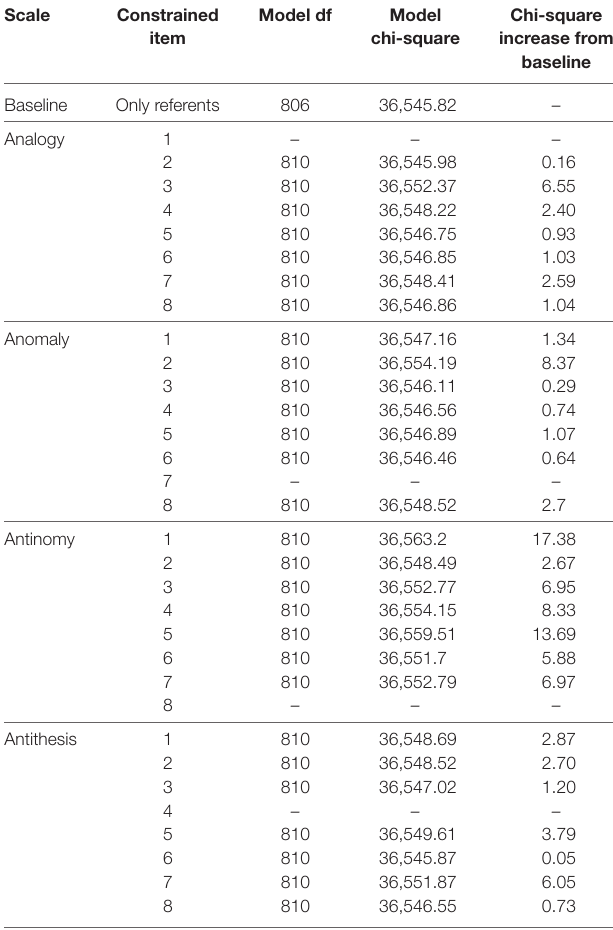
Referents for this analysis were Analogy 1, Anomaly 7, Antinomy 8, and Antithesis 4.